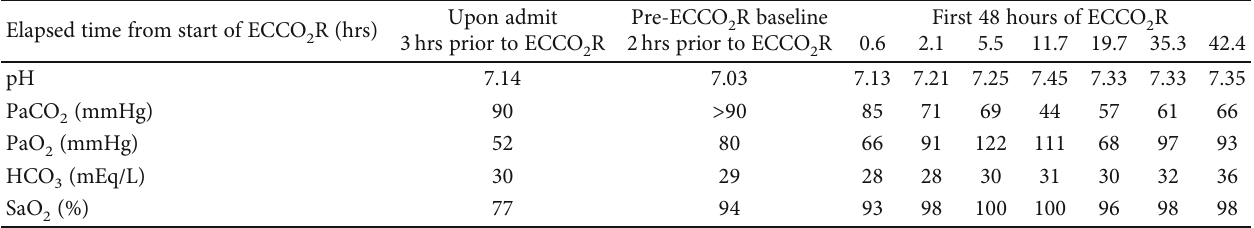
Table 1: Arterial blood gas measures prior to and during the fi rst 48 hours of Hemolung therapy. Upon admit Elapsed time from start of ECCO R (hrs) 2